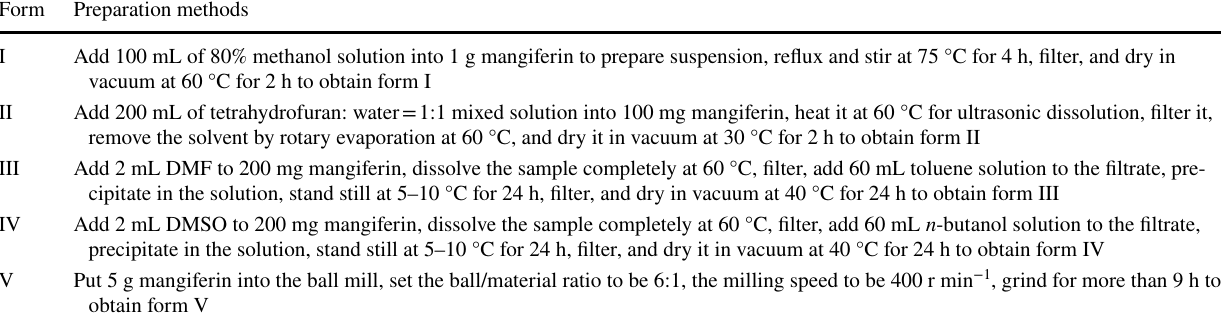
Table 1 The best preparation methods of five polymorphs of mangiferin Form